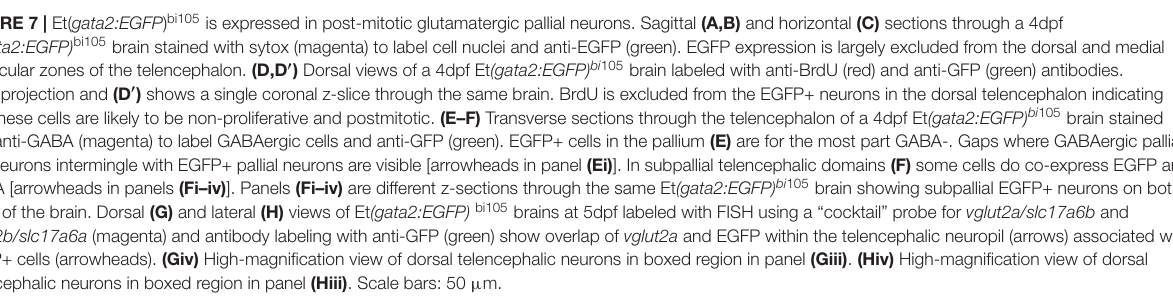
FIGURE 7 | Et( gata2:EGFP ) bi105 is expressed in post-mitotic glutamatergic pallial neurons. Sagittal (A,B) and horizontal (C) sections through a 4dpf Et (gata2:EGFP) bi105 brain stained with sytox (magenta) to label cell nuclei and anti-EGFP (green). EGFP expression is largely excluded from the dorsal and medial ventricular zones of the telencephalon. (D,D (cid:48) ) Dorsal views of a 4dpf Et (gata2:EGFP) bi 105 brain labeled with anti-BrdU (red) and anti-GFP (green) antibodies. (D) z-projection and (D (cid:48) ) shows a single coronal z-slice through the same brain. BrdU is excluded from the EGFP+ neurons in the dorsal telencephalon indicating that these cells are likely to be non-proliferative and postmitotic. (E–F) Transverse sections through the telencephalon of a 4dpf Et (gata2:EGFP) bi 105 brain stained with anti-GABA (magenta) to label GABAergic cells and anti-GFP (green). EGFP+ cells in the pallium (E) are for the most part GABA-. Gaps where GABAergic pallial interneurons intermingle with EGFP+ pallial neurons are visible [arrowheads in panel (Ei) ]. In subpallial telencephalic domains (F) some cells do co-express EGFP and GABA [arrowheads in panels (Fi–iv) ]. Panels (Fi–iv) are different z-sections through the same Et (gata2:EGFP) bi 105 brain showing subpallial EGFP+ neurons on both sides of the brain. Dorsal (G) and lateral (H) views of Et (gata2:EGFP) bi105 brains at 5dpf labeled with FISH using a “cocktail” probe for vglut2a/slc17a6b and vglut2b/slc17a6a (magenta) and antibody labeling with anti-GFP (green) show overlap of vglut2a and EGFP within the telencephalic neuropil (arrows) associated with EGFP+ cells (arrowheads). (Giv) High-magnification view of dorsal telencephalic neurons in boxed region in panel (Giii) . (Hiv) High-magnification view of dorsal telencephalic neurons in boxed region in panel (Hiii) . Scale bars: 50 µ